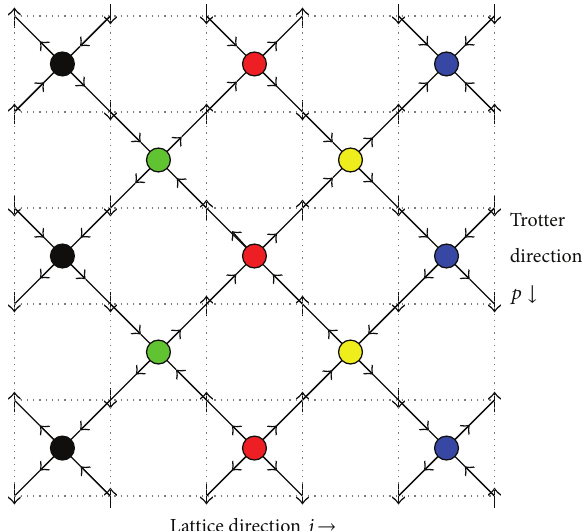
Figure 4: Lattice representation demonstrating how configurations of spins on the dotted vertices (represented by arrows ↑↓ ) give rise to arrow configurations about the solid